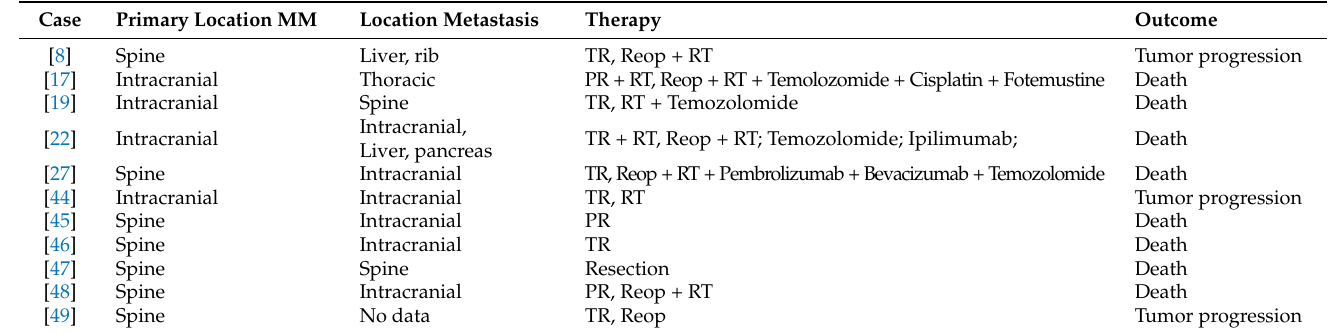
Table 4. Metastasis: Metastasis led to either tumor progression or death. TR = Total Resection, PR = Partial Resection, RT = Radiotherapy, Reop = Reoperation.